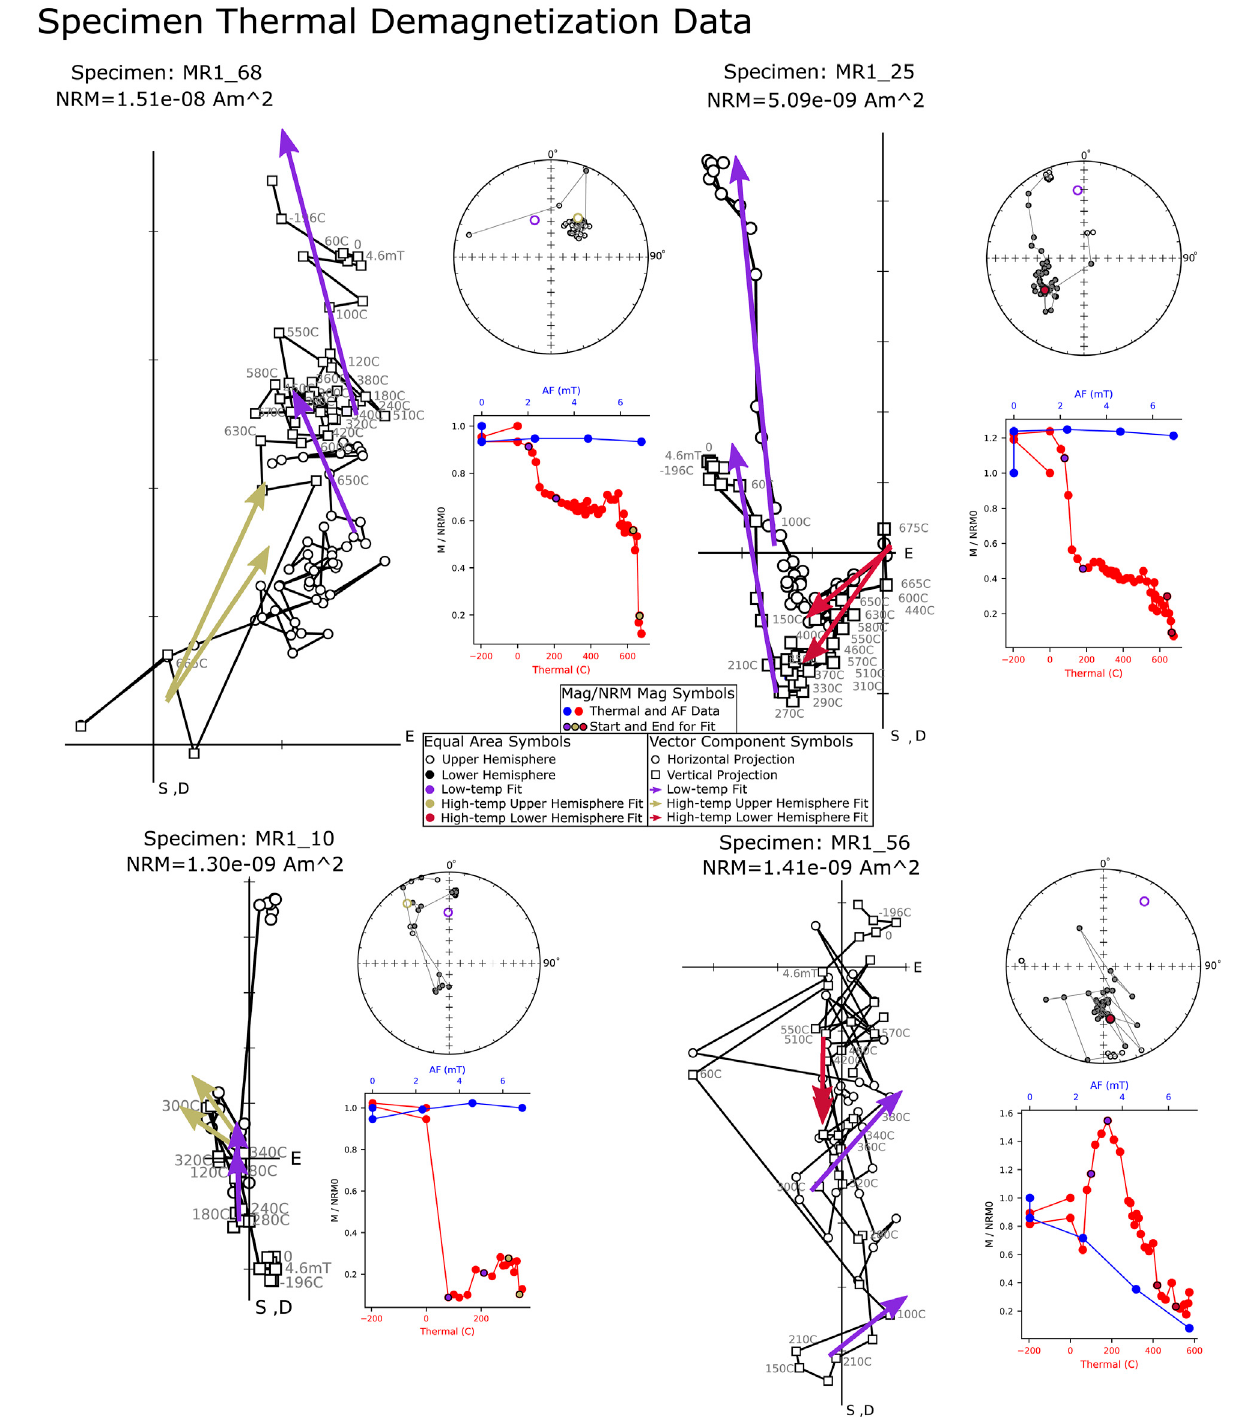
FIGURE 3 | Paleomagnetic data. Equal area, magnetization normalized to initial magnetization (M/NRM0, NRM (cid:1) natural remanent magnetization), and Zijderveld plotsofdemagnetizationdataforfourrepresentativesamplesintheupper(samplesMR1-68andMR1-10)andlower(samplesMR1-25andMR1-56)hemispheresintilt- corrected coordinates. MR1-68 and MR1-25 are among the best samples with well-de fi ned, origin-reaching, high-temperature components and the high-blocking temperatures indicative of detrital hematite. MR1-10 and MR1-56 are noisier samples.